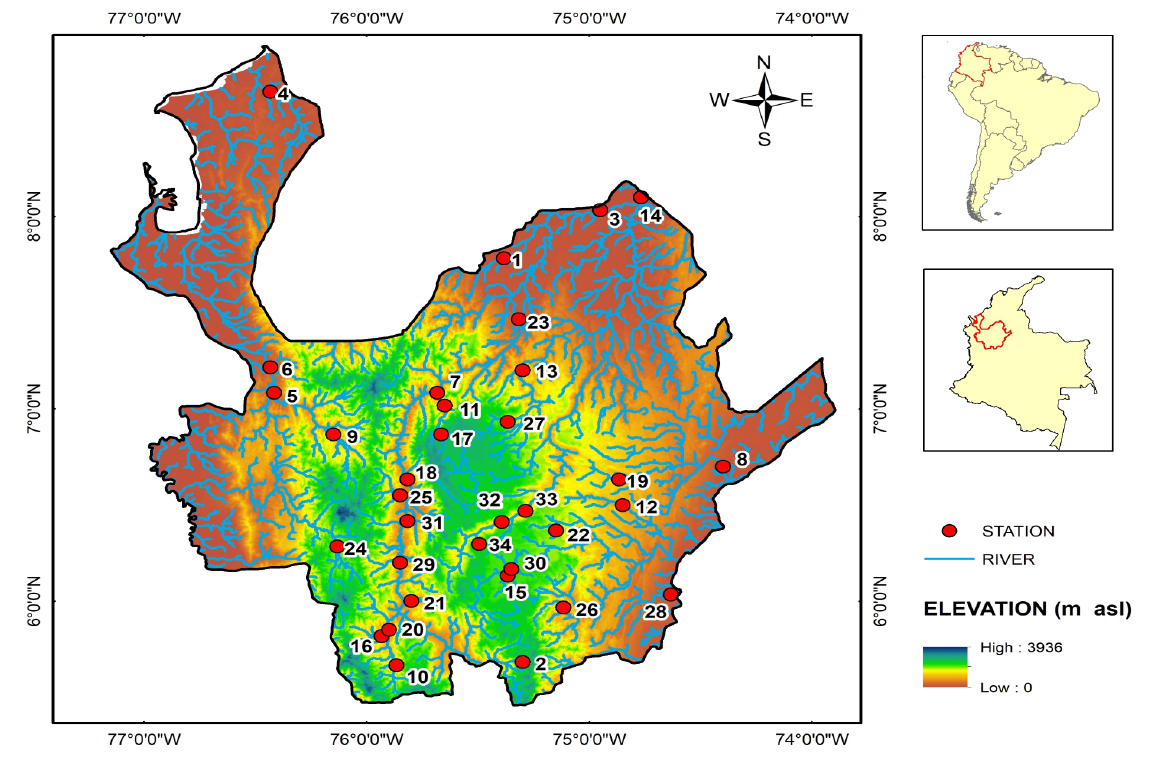
Figure 1. Geographical distribution of the streamflow gauging